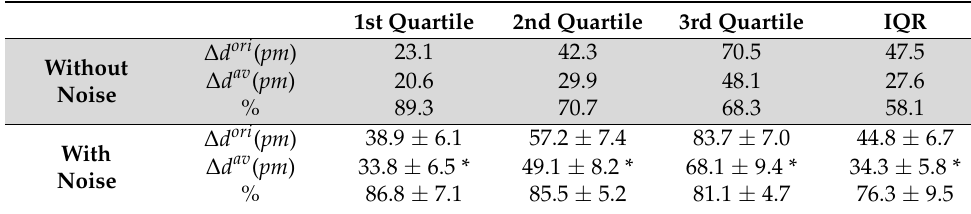
Table 1. Detailed values of the displacement root-mean-square error (RMSE) distribution in simulated interferograms without and with noise using the original ( ∆ d ori ) and the proposed estimator ( ∆ d av ). Data with noise are presented as the mean ± standard deviation. * Statistically significant at p < 0.001.